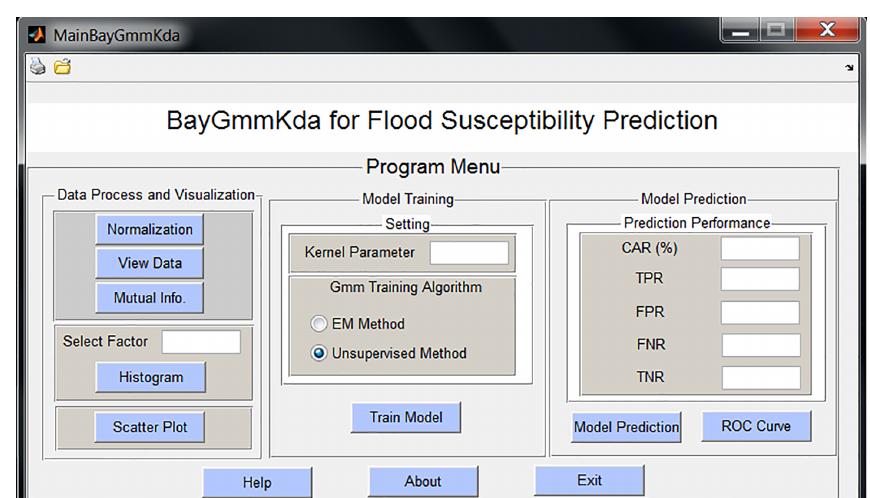
Figure 6. The proposed BayGmmKda.